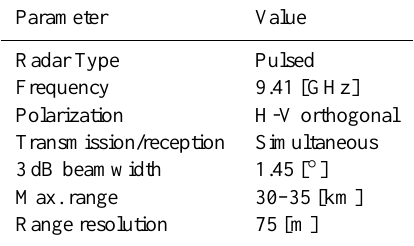
Table 2. Main characteristic of the X-band dual-polarization radar MXPol. Additional information on the instrument can be found in Scipion et al.